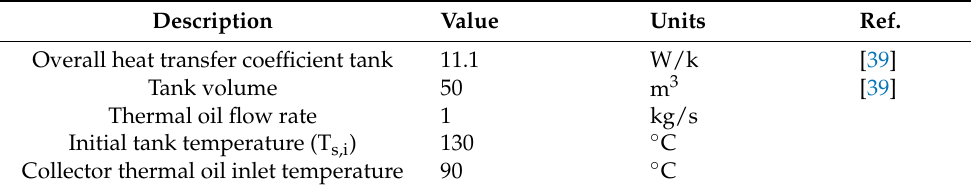
Table 2. Cont. Description Value